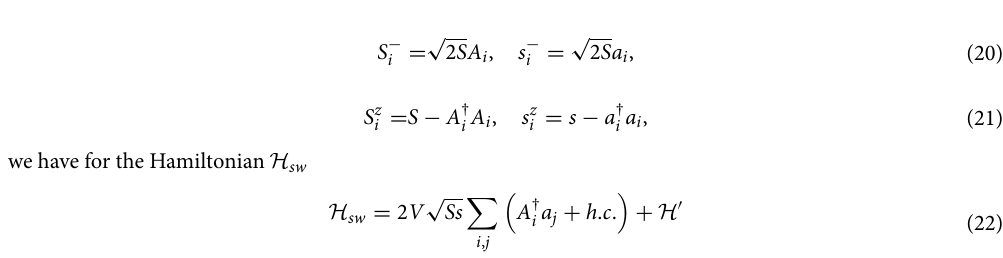
Figure 2. Behavior of the potential of interaction between the electron with the ferromagnetic domain wall, V ( x ), where the width of the wall is δ